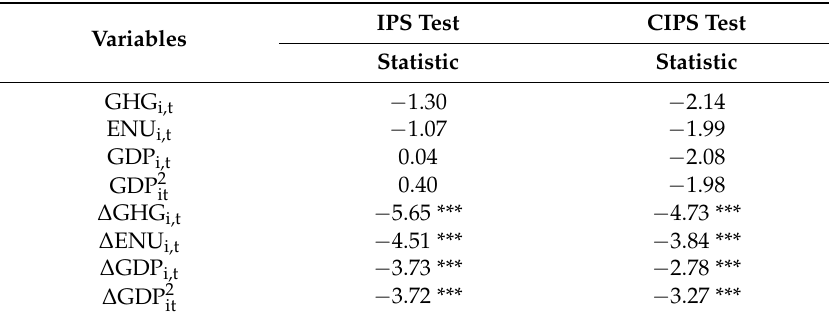
Table 3. Panel unit root test results for all